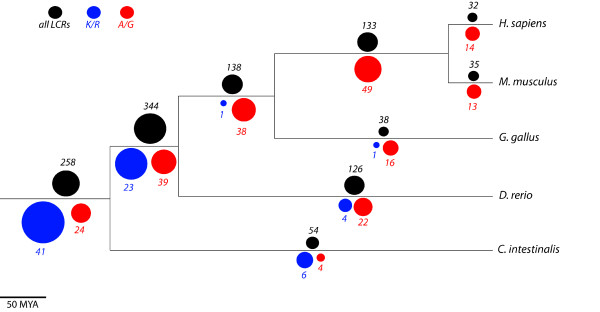
Relative abundance of low-complexity regions (LCRs) at different phylogenetic depths. The area of the circles is proportional to LCR relative frequencies. The number of LCRs at each branch is indicated. In black, data for all LCRs. In blue, data for LCRs enriched in positively charged amino acids (K and R). In red, data for LCRs enriched in alanine (A), glycine (G) or both. The LCR phylogenetic distribution of LCRs labeled in blue, and of LCRs labeled in red, deviated significantly from the expected one considering all LCRs (Fisher’s exact test p < 10-5).